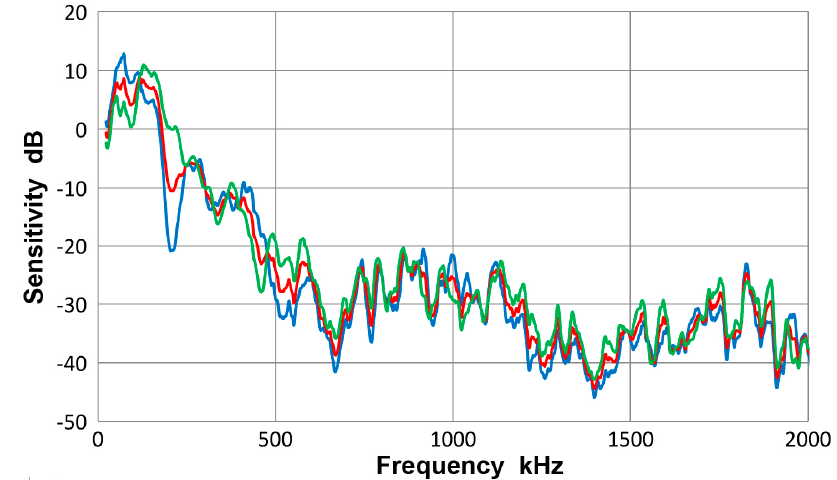
Figure 16. Receiving sensitivity of PAC R15 sensor. Red -averaged guided wave sensitivity, blue -Lamb waves for 12.7 and 6.4 mm plates, green -bar waves for 12.7 and 6.4 mm bars.